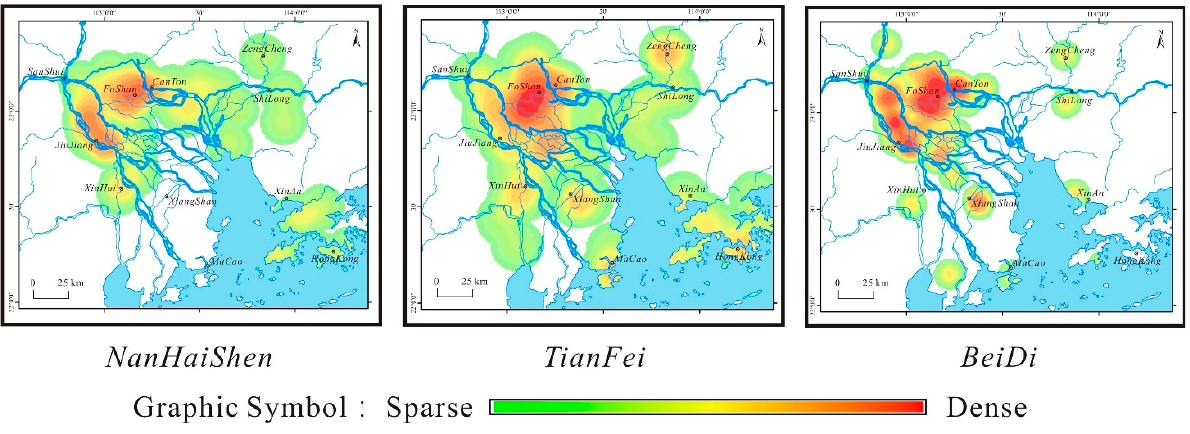
Figure 6. Comparison of spatial pattern of the Water Deities. Table 2. Space and propagation characteristics of the Water Deities.